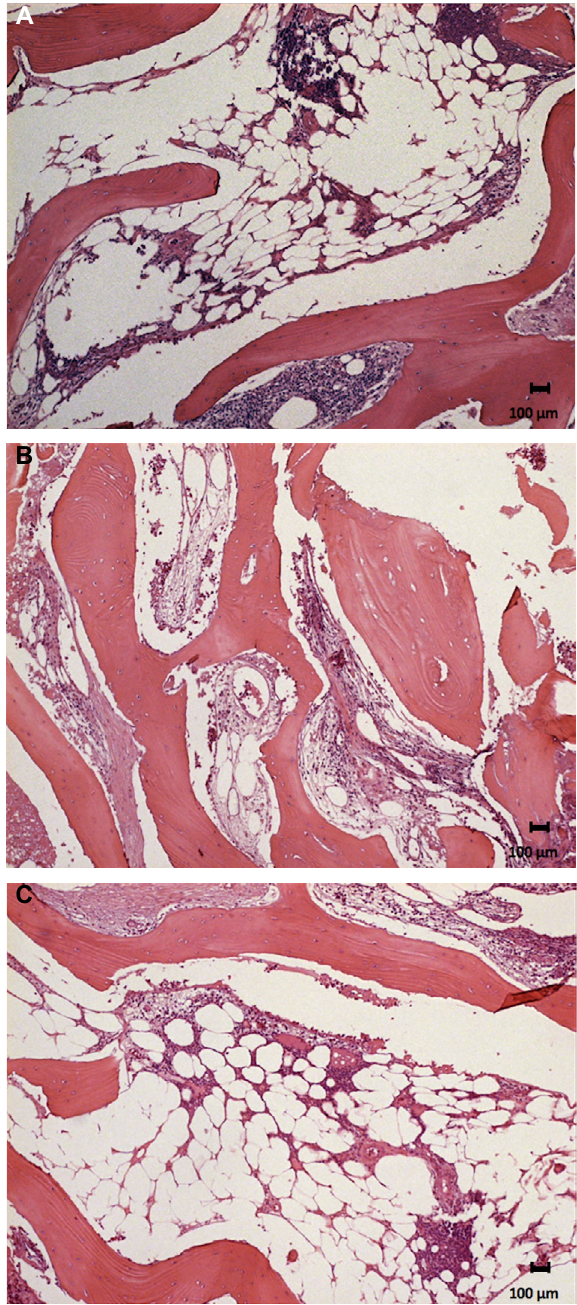
Figure 3- Image showing the histological section from group 2. Lamellar bone formation in a well-cellularized connective tissue in A: Pristine bone region; B: Intermediate region; C: Apical region. Hematoxylin & eosin stain, x12.5